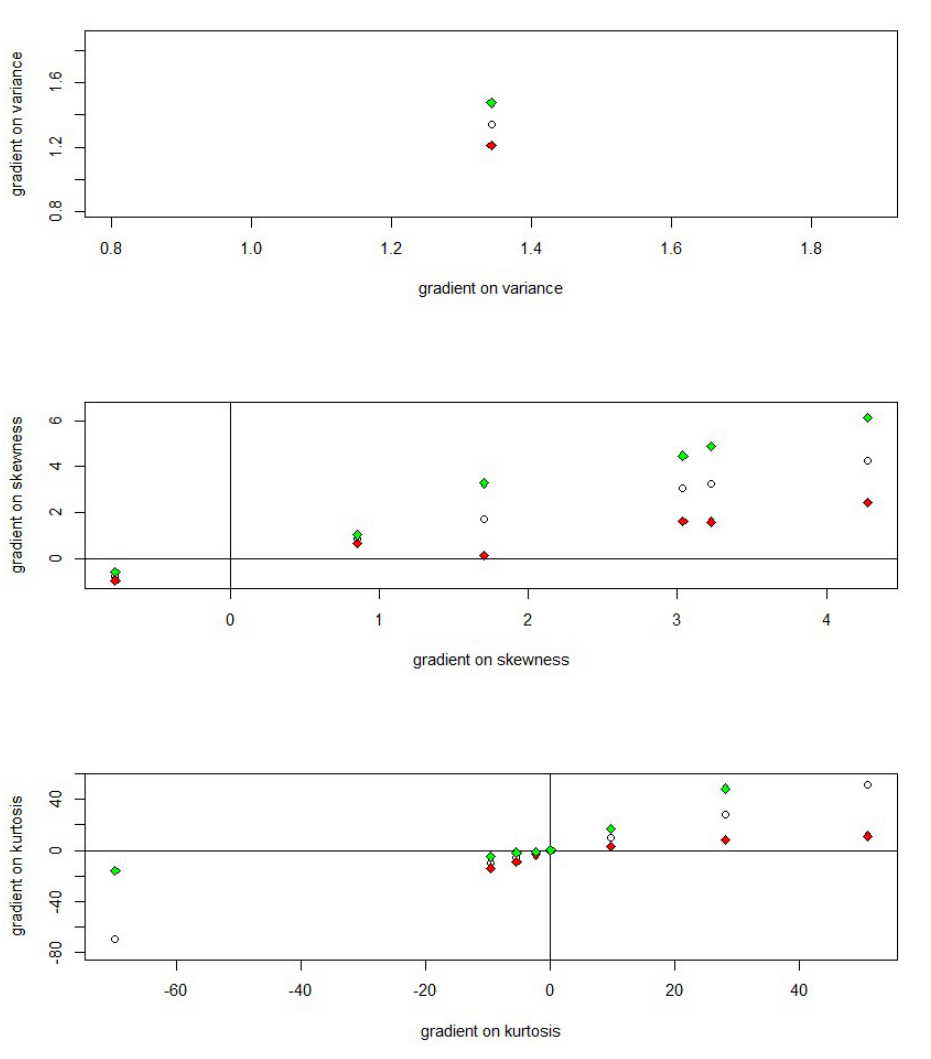
Figure 14. Statistically significant spline gradients (Step 4) on 45 ◦ plot.